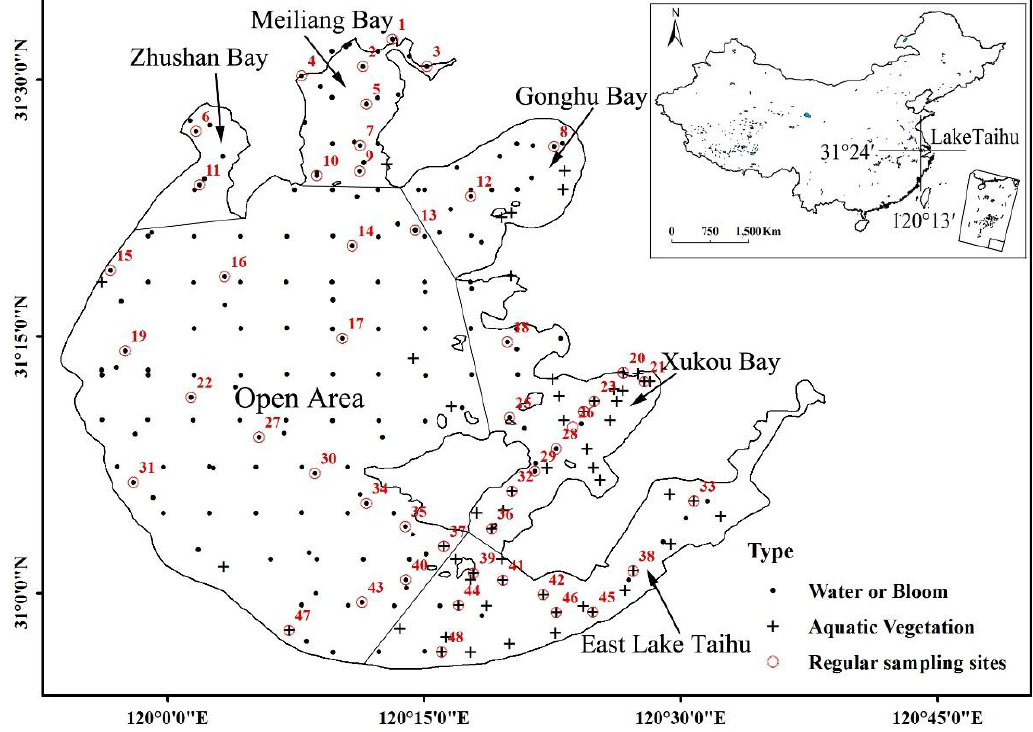
Figure 1. The locations of 244 ground-truth samples collected in 2013 (presence of aquatic vegetation is denoted by black crosses and absence is denoted by black dots) and the annual sampling sites from 2008–2012 (represented by numbered red circles; site 45 was not sampled in 2008 and 2009); the chart in upper right box is the map of South China